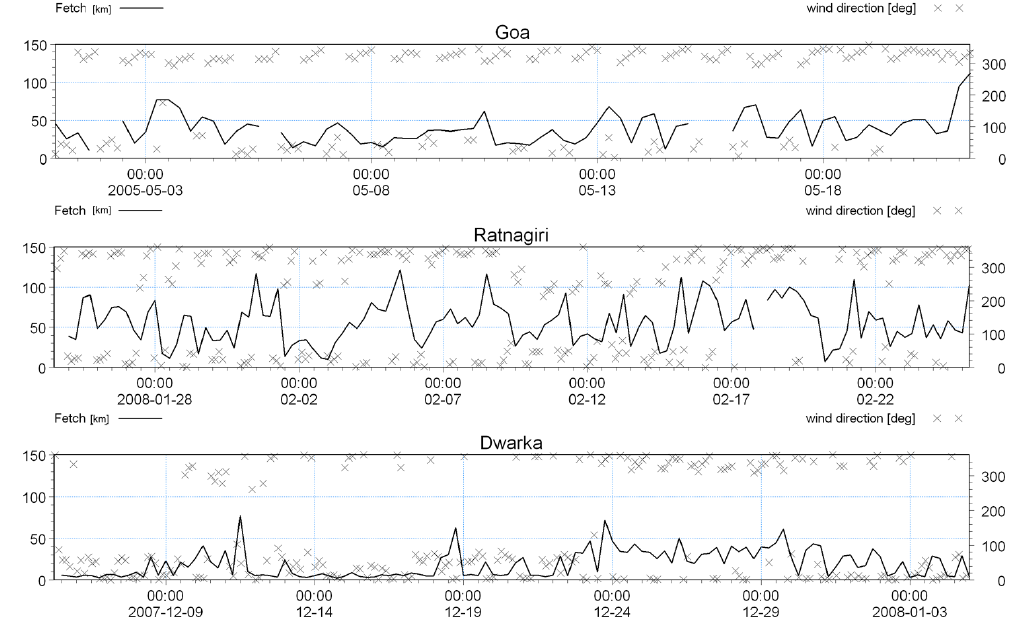
Fig. 8. Fetch and wind direction off Goa, Ratnagiri and Dwarka along the west coast of India.